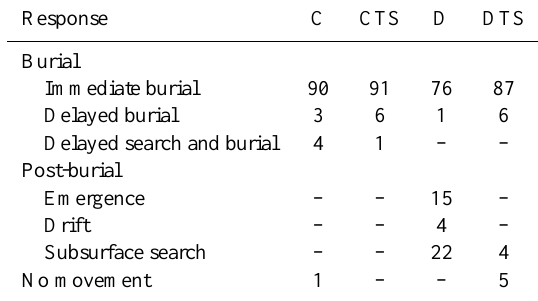
Table 4. Macomona liliana . Behavioural response of post- settlement juveniles placed onto the surfaces of TS-treated and bare intertidal (CTS, C) and depleted (DTS, D) sediment. Data repre- sent the number of individuals that exhibited the behaviour, a dash indicates that a behaviour was not